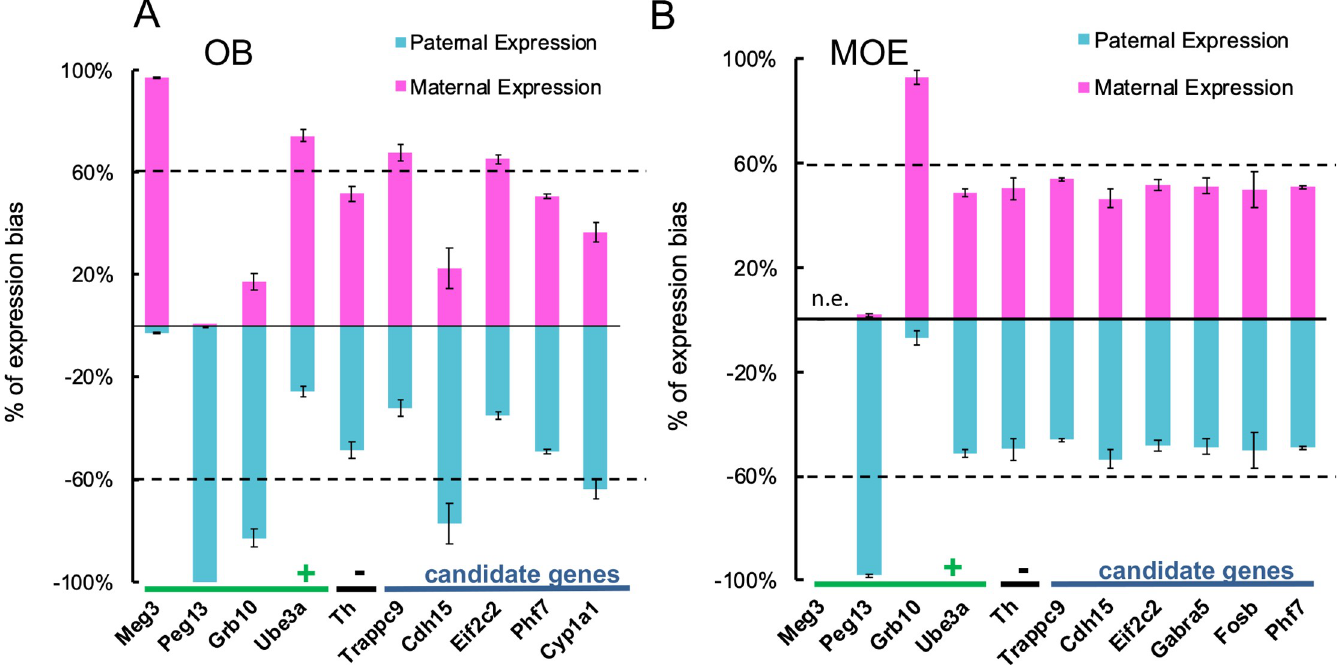
Fig 2. Validation of parental allelic biased gene expression. Allele-specific gene expression was determined for selected genes using Allelic Discriminant qRT-PCR on F1 reciprocal hybrid samples (females, aged 14 weeks) of the ( A) olfactory bulb and (B) main olfactory epithelium. The percentage of parental and maternal expression is shown as an average of the results from two reciprocal crosses with n = 5 for each cross. Four genes with previous identified parent-of-origin expression ( Meg3 , Peg13 , Ube3a and Grb10 ) were as positive controls and Th was a negative control. As expected, Meg3 showed monoallelic maternal expression and Peg13 showed monoallelic paternal expression; Meg3 did not express in non-brain tissue while Peg13 did. Ube3a showed brain-specific imprinting with maternal allelic-biased expression. Grb10 shows opposite imprinting in the brain (maternal allelic-biased) versus in a non-brain tissue (paternal allelic-biased). Th expression was bi-allelic in both tissues as expected. For candidate genes, we confirmed that Trappc9 and Eif2c2(Ago2) showed maternal allelic-biased and Cdh15 showed paternal allelic-biased expression, both were in OB but not in MOE, suggesting brain specific imprinting. The expression of Garba5 and Fosb in MOE and Phf7 in both tissues was bi-allelic; but Cyp1a1 showed a paternal biased expression in the OB, as a previously unknown gene with brain-specific imprinting.